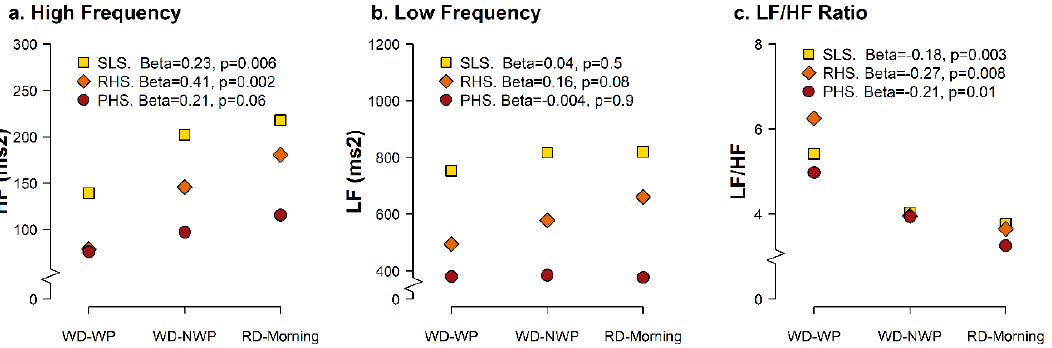
Figure 2. Age- and smoking-adjusted geometric mean for high frequency (HF) (panel a ), low frequency (LF) (panel b ) and LF/HF ratio (panel c ) in consecutive periods of the working and of the resting days, and their linear trend over time (beta-coefficient) within each work stress group.